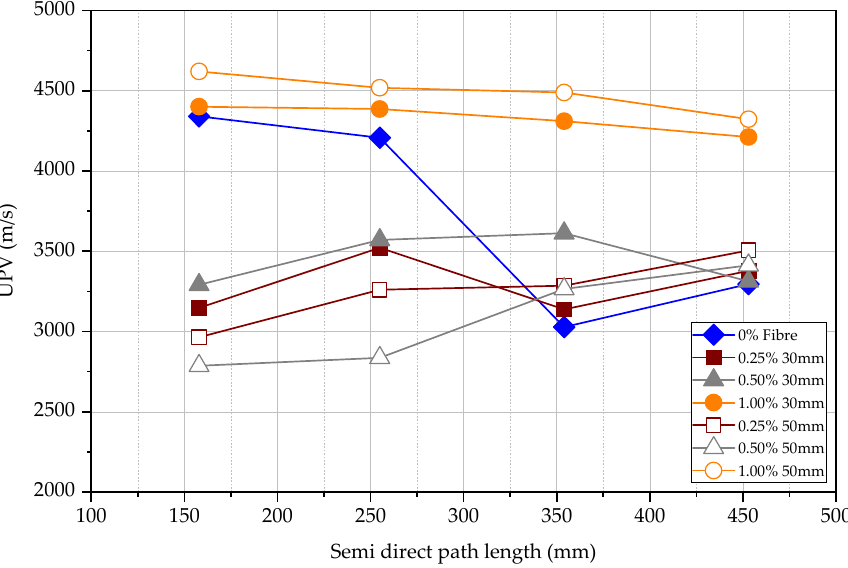
Figure 15. Semi-direct UPV measurement vs. path length at 3 days.